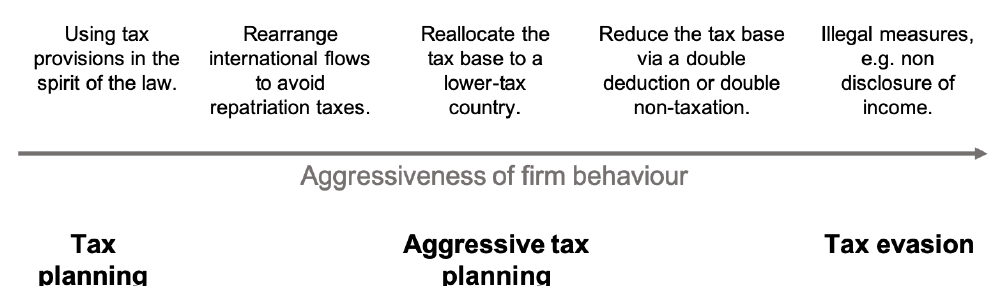
Figure 1. Boundaries of aggressive tax planning behaviour retrieved from [19].